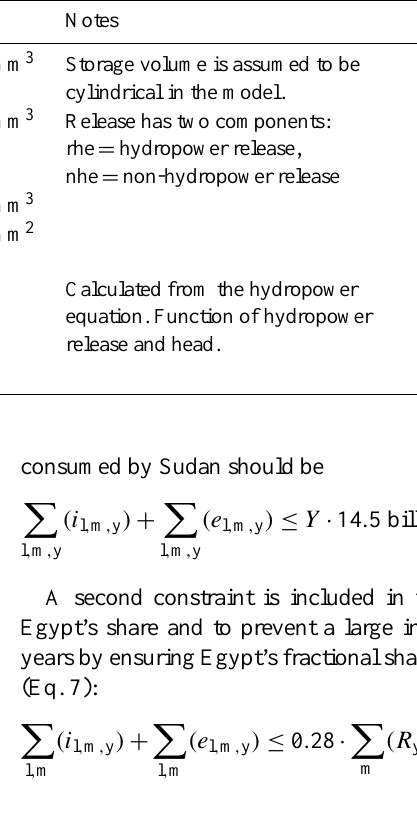
Table 2. SHOM variable